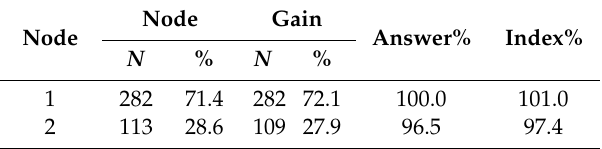
Table 15. Earnings for nodes: target those who do use WhatsApp.